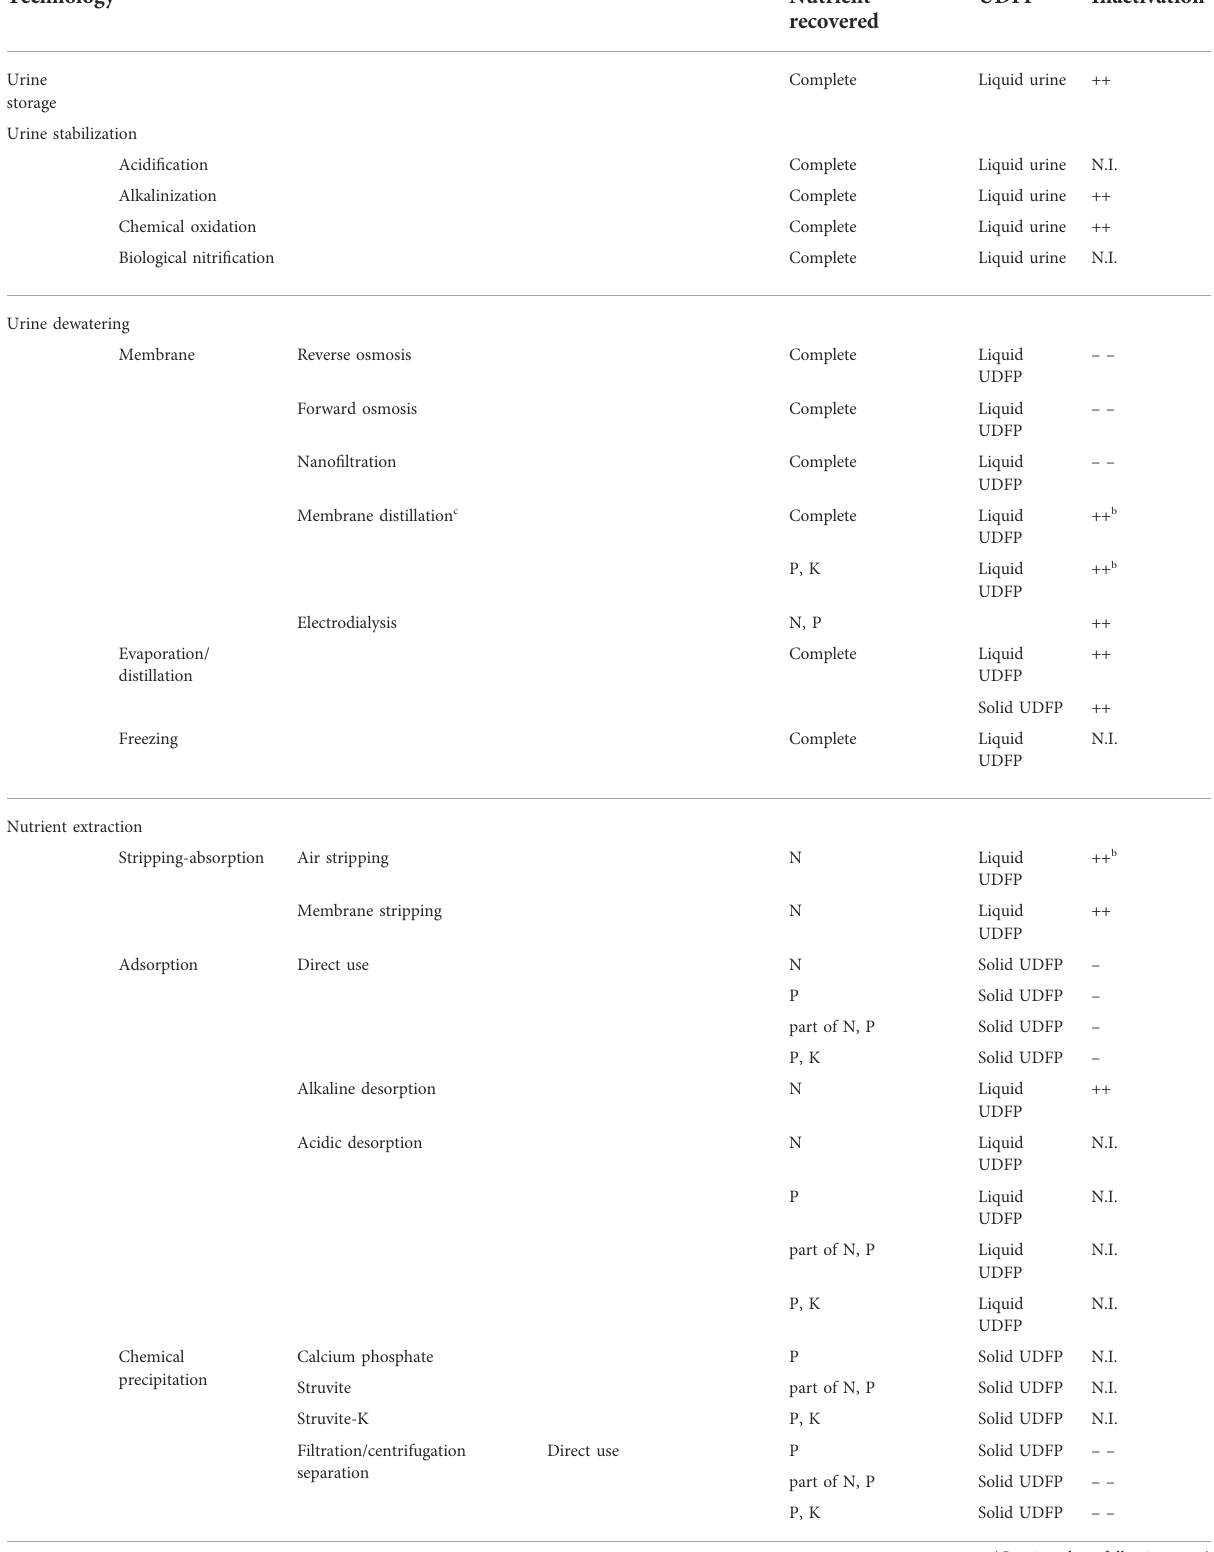
TABLE 2 An overall assessment of pathogens inactivation in urine treatment technologies and the related